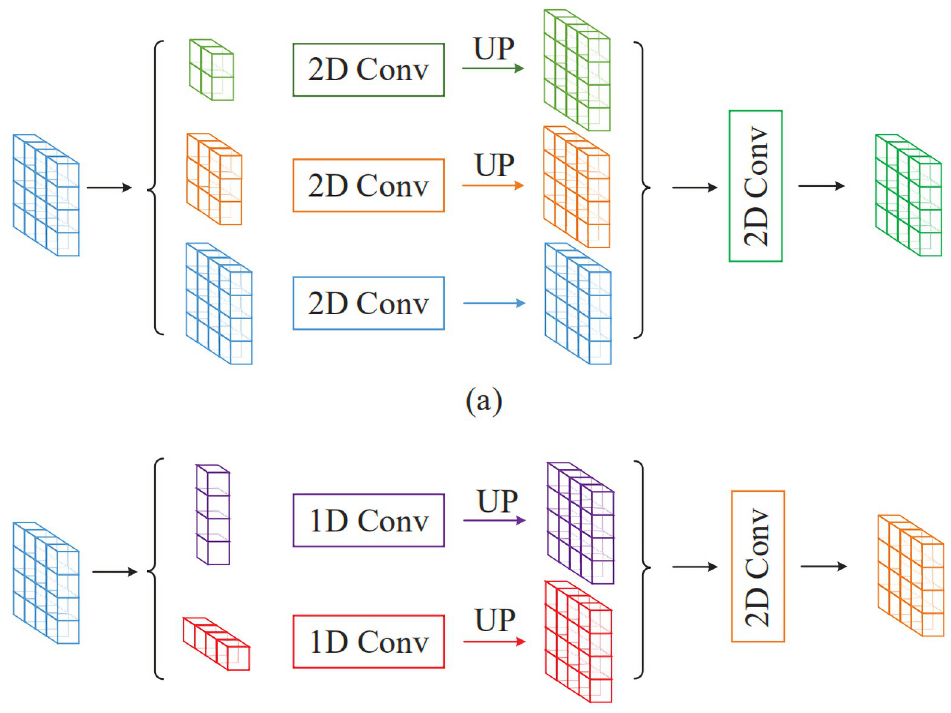
Fig 3. MPM structure